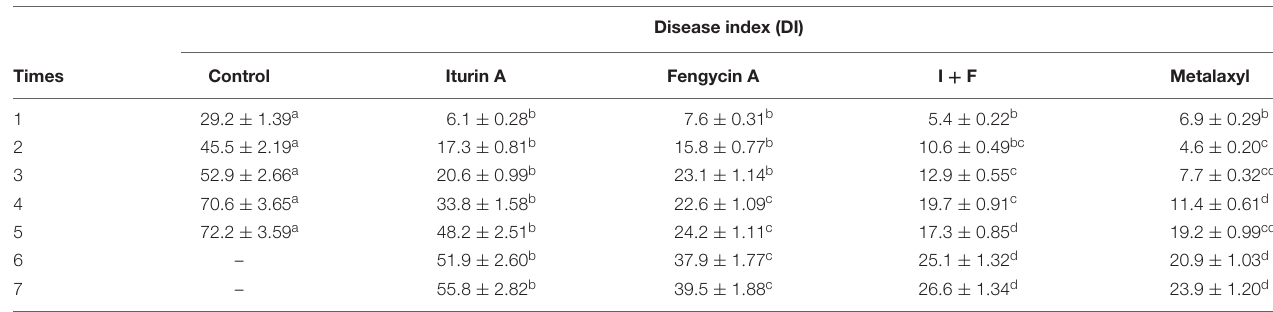
TABLE 6 | Disease index of potato late blight in field trials after CLPs